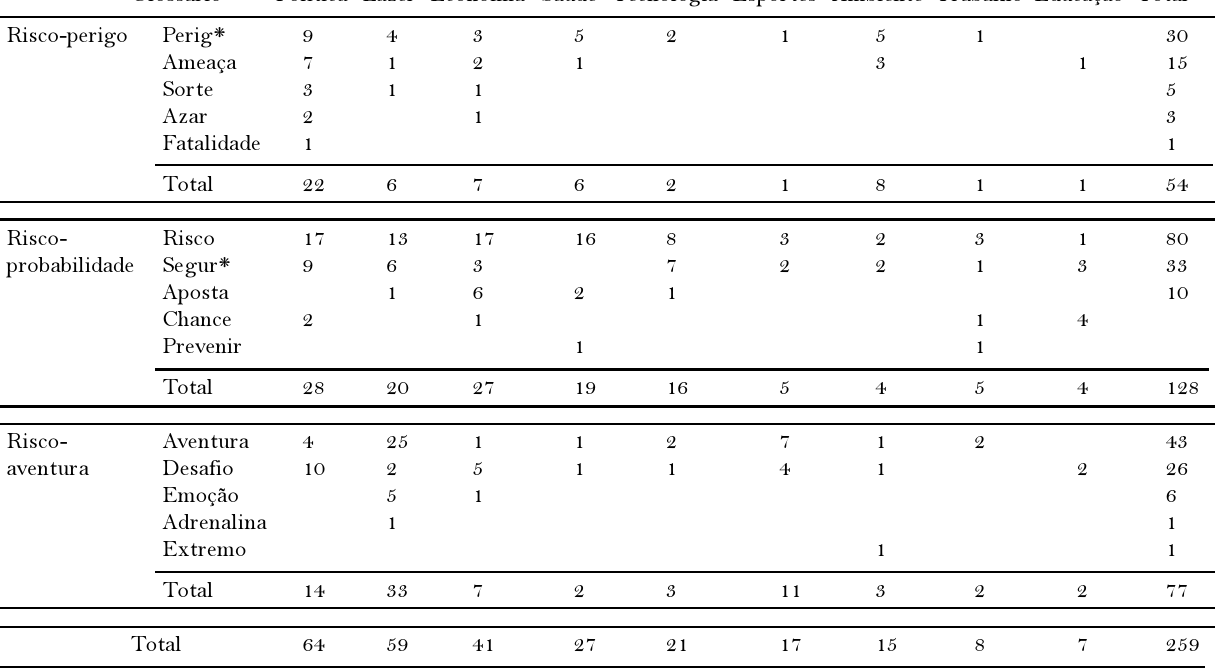
Análise Sincrônica: Glossário do Risco por Tradição e Área